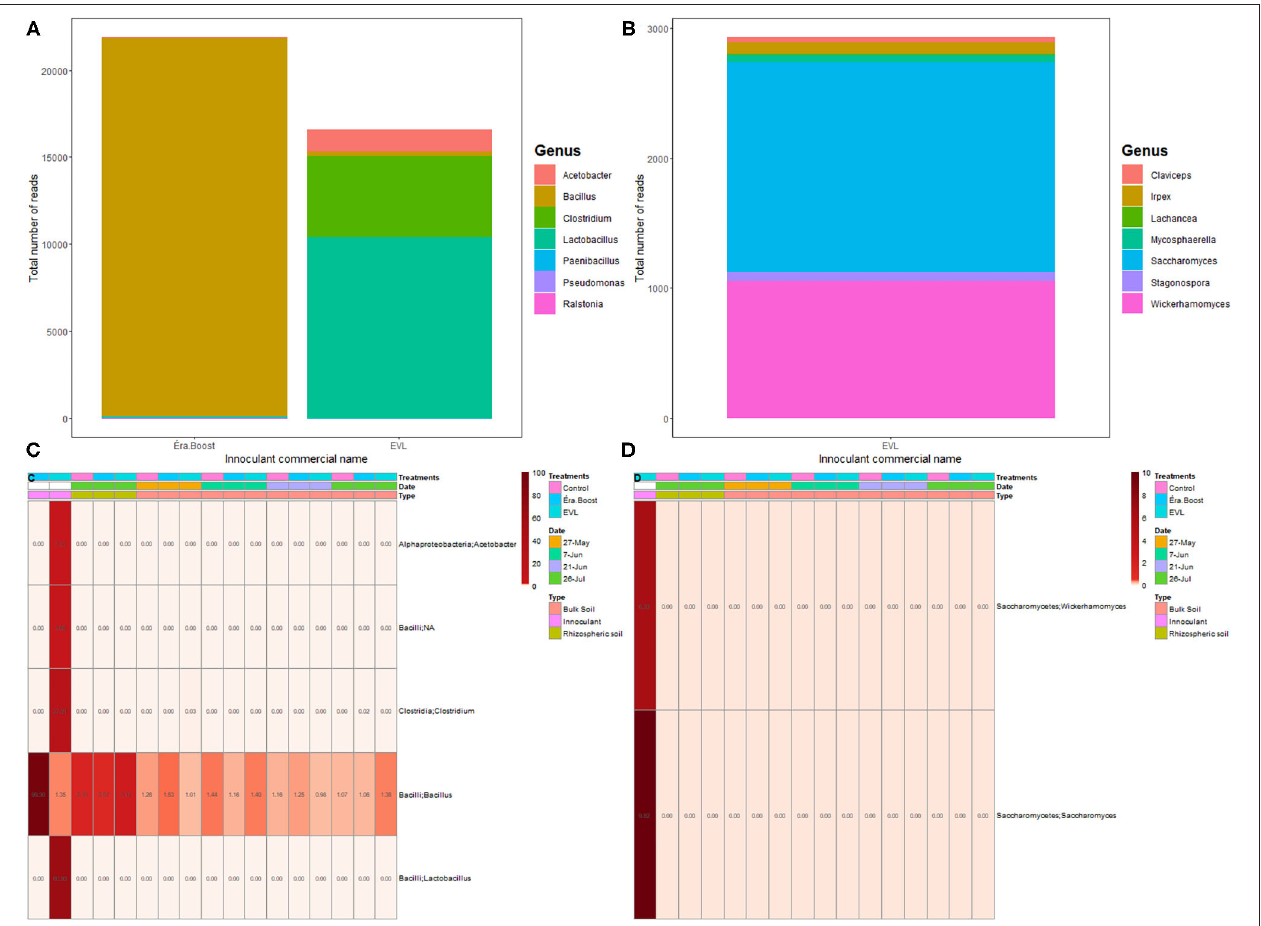
FIGURE 1 | Commercial inoculants EVL and EV. The prokaryotic (A) and fungal (B) compositions at the Genus level. Heatmaps of prokaryotic (C) , and fungal (D) genera found in commercial inoculants with relative abundances > 1% in all samples collected. Inoculation of soil occurred between May 27th (orange annotation) and June 07th (teal